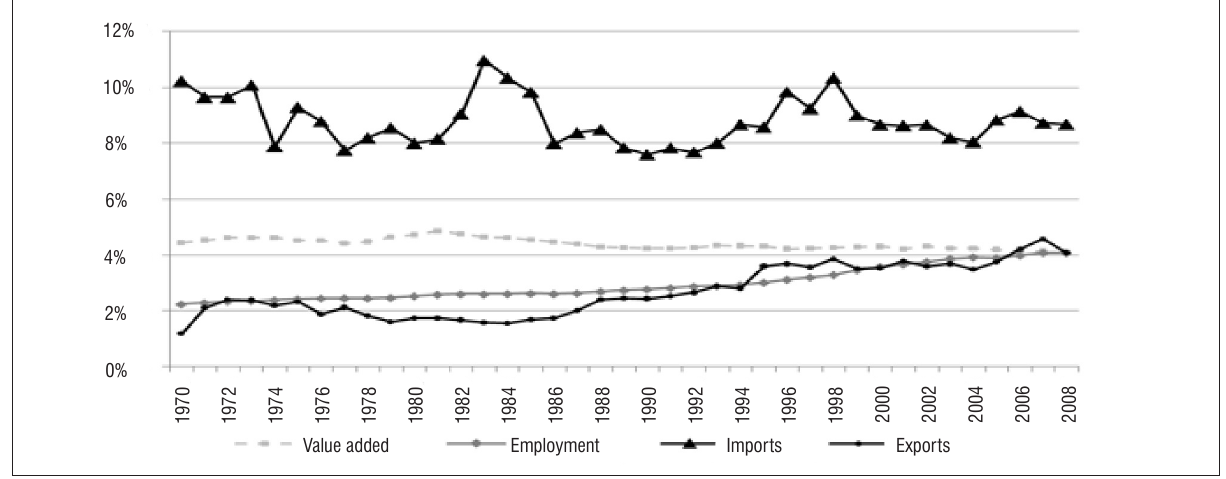
Contribution of copyright-based industries to the South African economy (value added, employment, imports and exports) from 1970 to